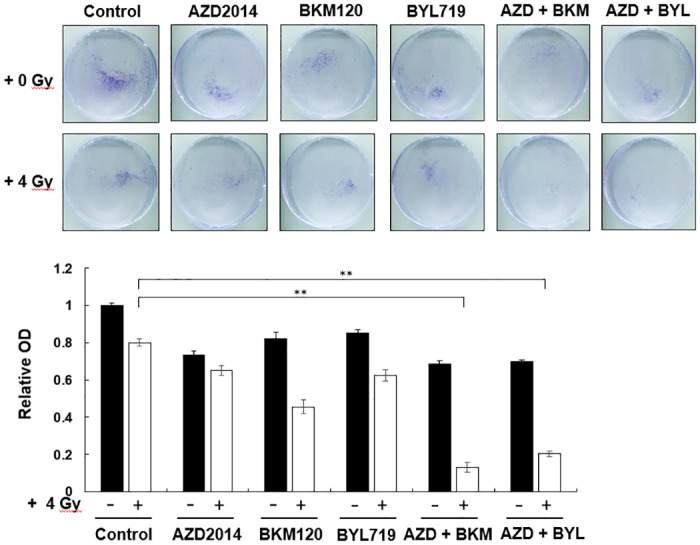
Combination treatment with PI3K/mTOR inhibitors and IR increased radiosensitivity in OML1-R cells.The cells were treated with each PI3K/mTOR inhibitor alone or with the combination treatment of PI3K/mTOR inhibitors and IR. After 14 days, colonies were stained with crystal violet and quantified by an ELISA reader. Data are presented as mean ± SD, and the asterisks indicate significant difference. *P < 0.01 compared with the control group.